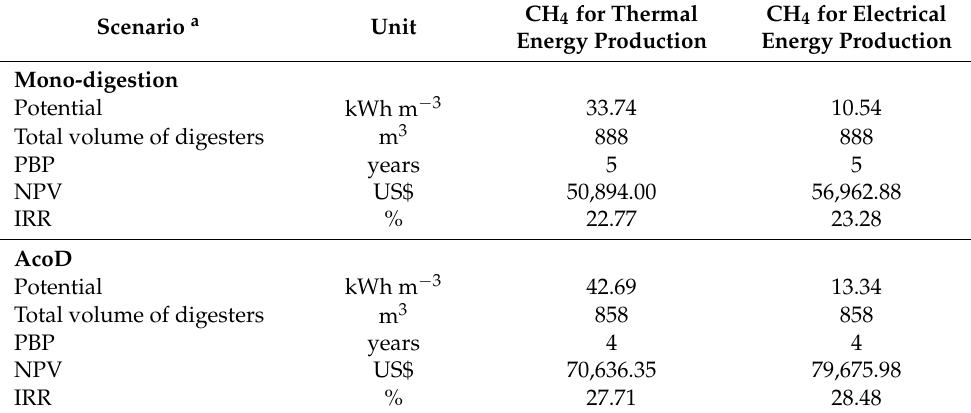
Table 8. Results of the economic study for the implementation of anaerobic digestion of the slaugh- terhouse wastewater streams and